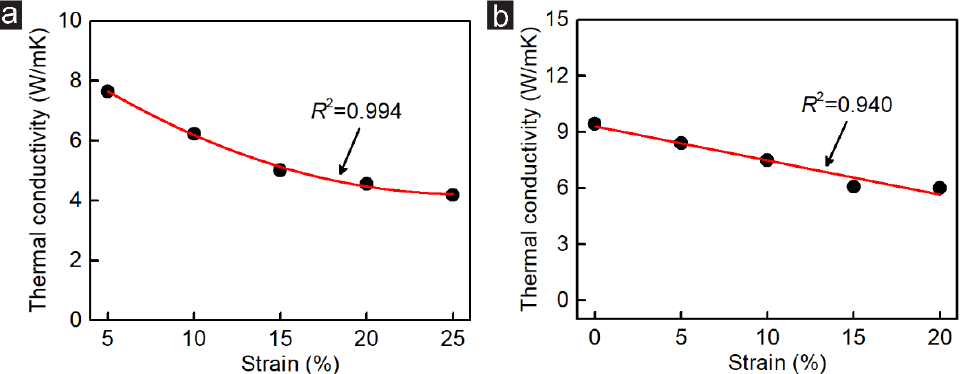
Figure 9. Relationship between the strain rate and the thermal conductivity on the ( a ) zigzag-incised GK (Sample ZZ_1_1) and ( b ) armchair-incised GK (Sample AC_3_1).